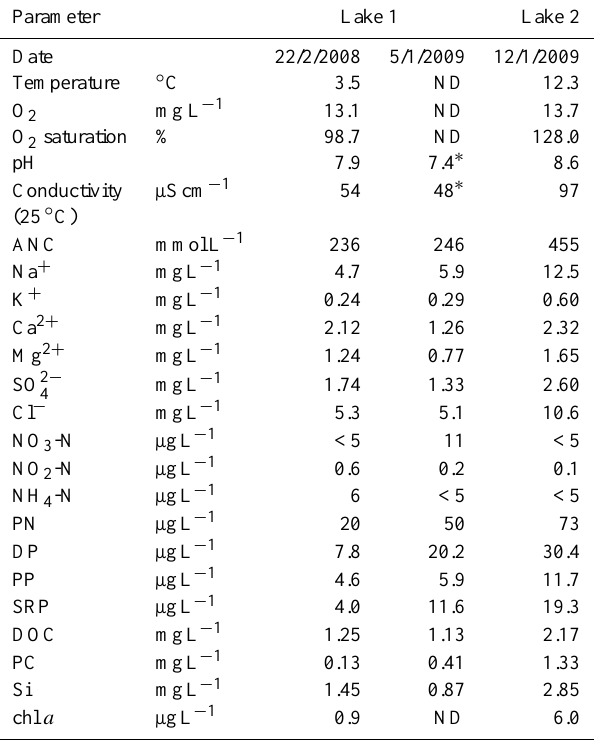
Table 1. Physico-chemical characteristics and chlorophyll a con- centrations in lake water. Samples were collected from surface of lakes. ND – not determined, ANC – acid neutralisation capacity, PN – particulate nitrogen, DP – dissolved phosphorus, PP – par- ticulate phosphorus, SRP – dissolved reactive phosphorus, DOC – dissolved organic carbon, PC – particulate carbon, ∗ – laboratory